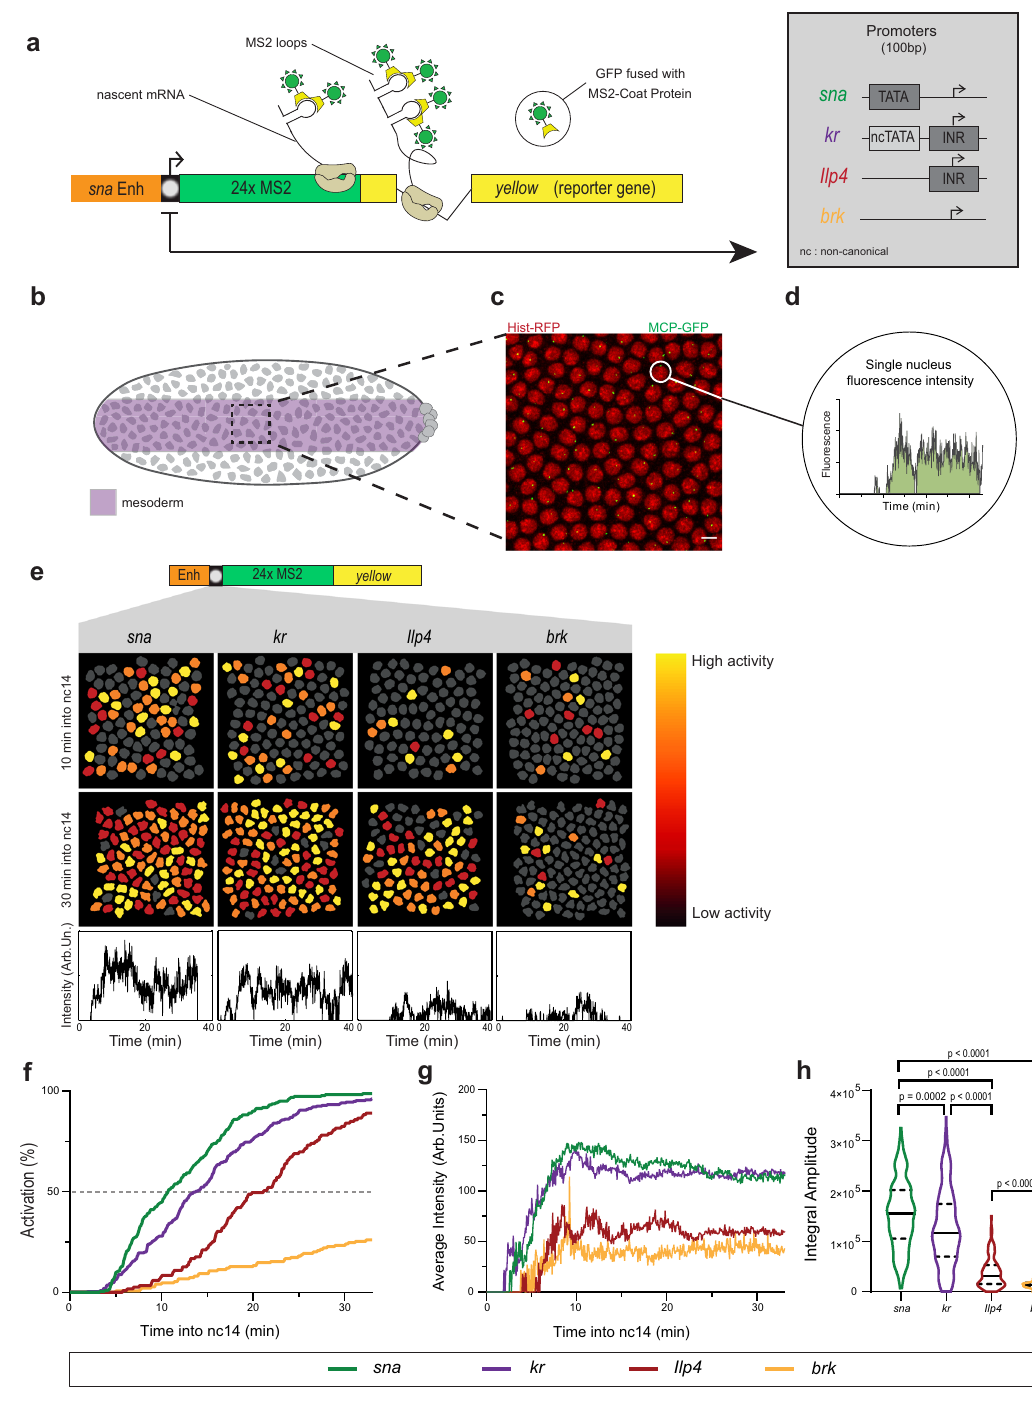
(Fig. 1f), de fi ned as the temporal coordination of activation among a spatially de fi ned domain. The TATA-driven sna and INR-driven kr minimal promoters showed a rapid activation with a t50 (the time needed for 50% of nuclei within the region of interest to show GFP puncta) of 11 min and 14 min, respectively while the INR-driven Ilp4 promoter was delayed with t50 of 21 min. The brk core promoter did not surpass 24% of nuclei acti- vated throughout nc14. In addition to differences in synchrony, the overall mRNA production also varied between transgenes (Fig. 1g). Within our four developmental promoters, promoters showing more rapid reactivation in nc14 also had higher TS intensity in active